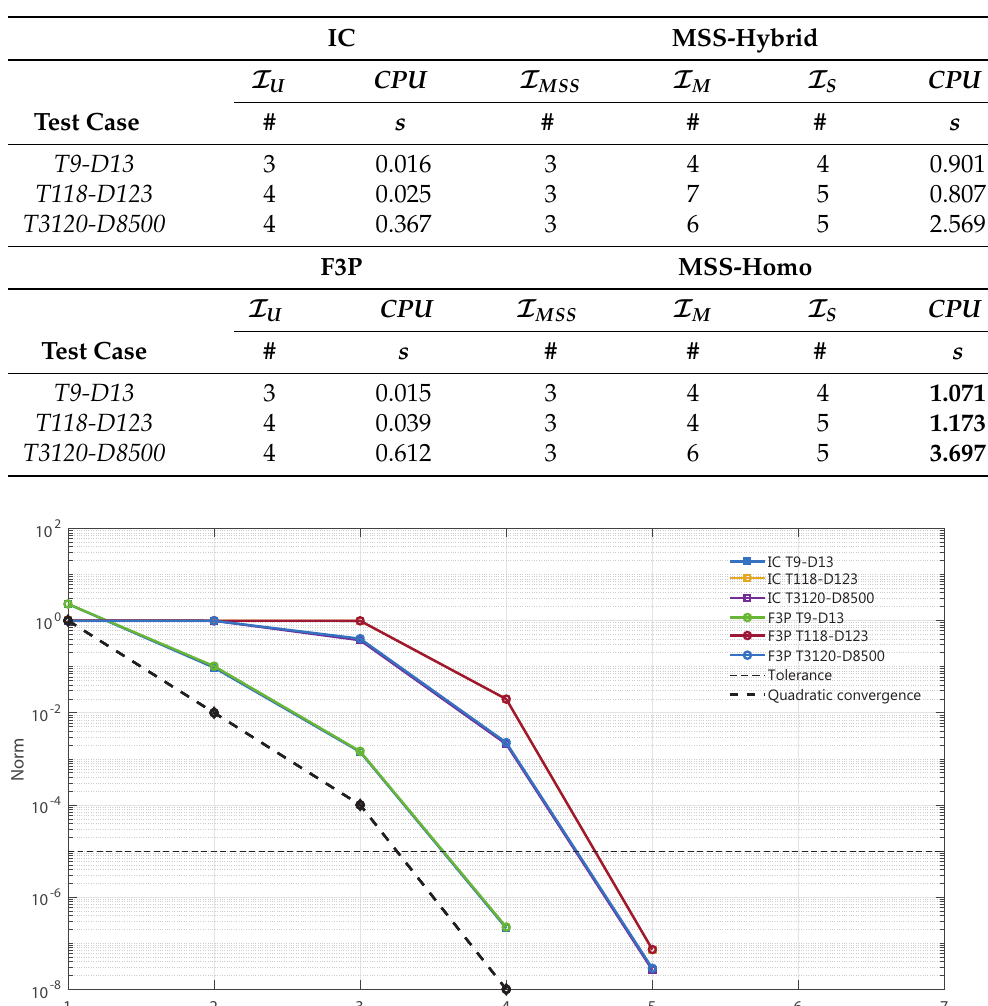
Table 4. Comparison on number of iterations (for the MSS method: I MSS of the MSS scheme and I M and I D , the average number of iterations per sub domain) and CPU time of the integration methods, of three test cases. The top table displays methods applied to hybrid and the bottom one on homogeneous networks. The slowest CPU times are printed in bold.